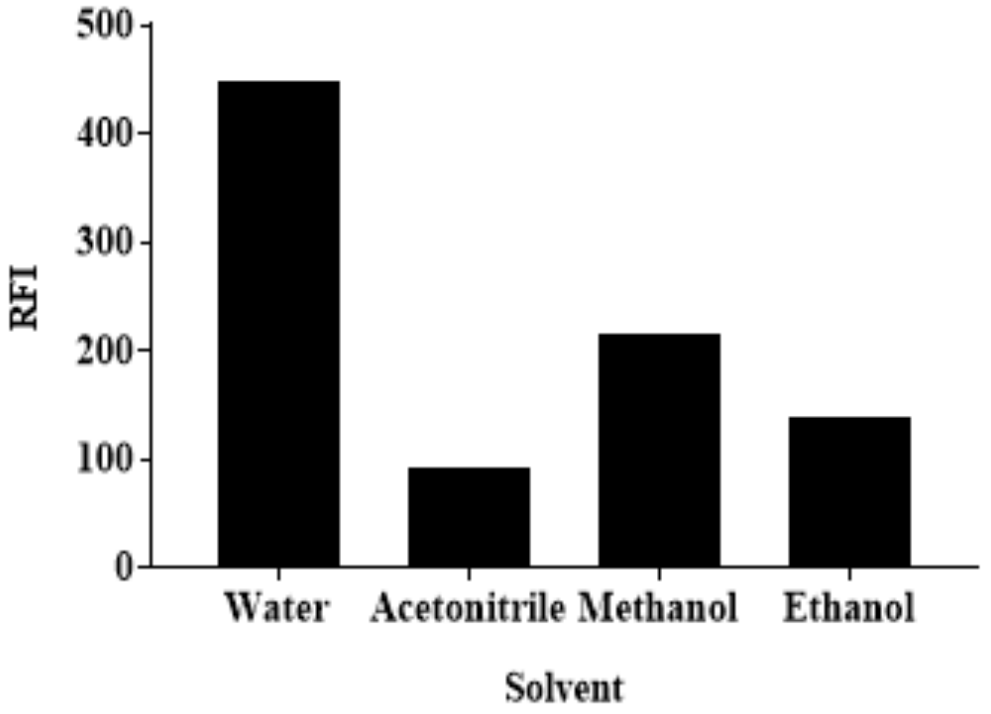
Figure 6. The effect of the solvent on the RFI of ALC (250 ng mL − 1 ) in a Cr RH 40 (1%, w / v ) me ‐ dium.